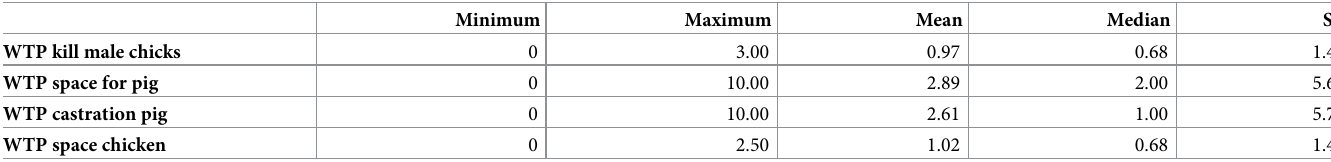
Table 2. Descriptive statistics for WTP in